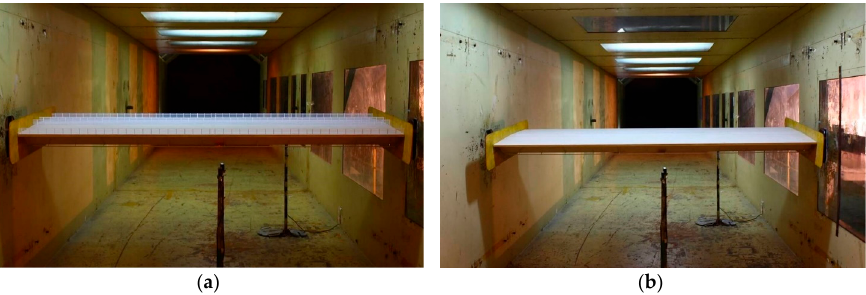
Figure 4. The test models for response measurements: ( a ) the test model in the operation stage; and ( b ) the test model in the construction stage.